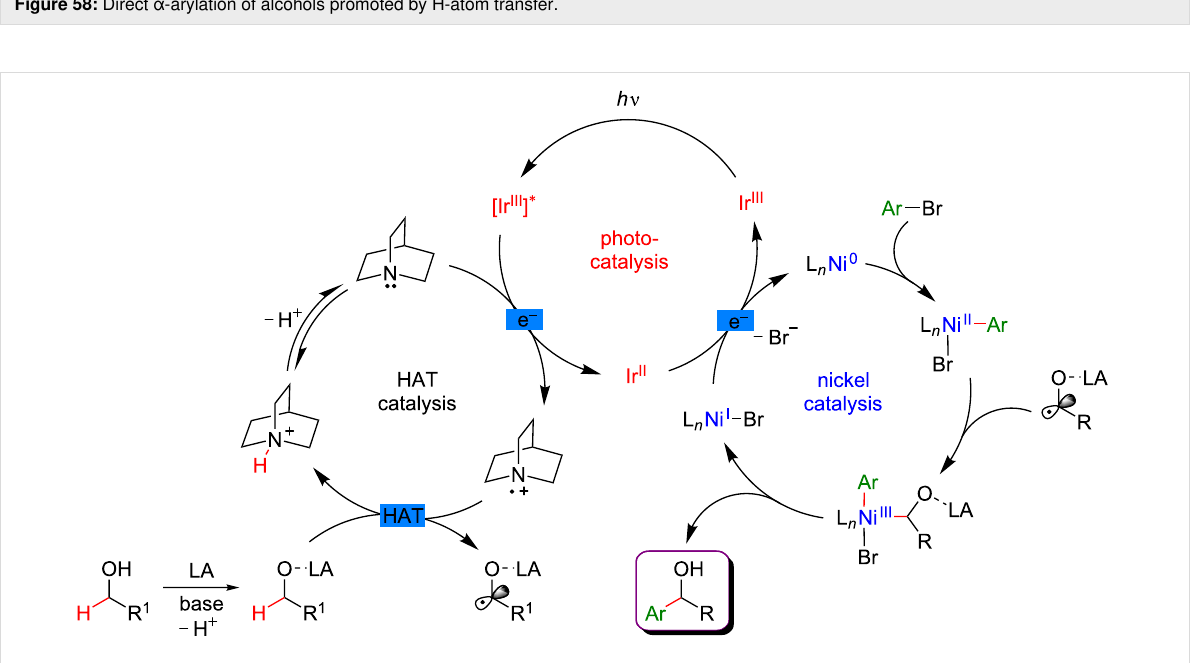
Figure 59: Proposed mechanism for the direct α -arylation of alcohols promoted by